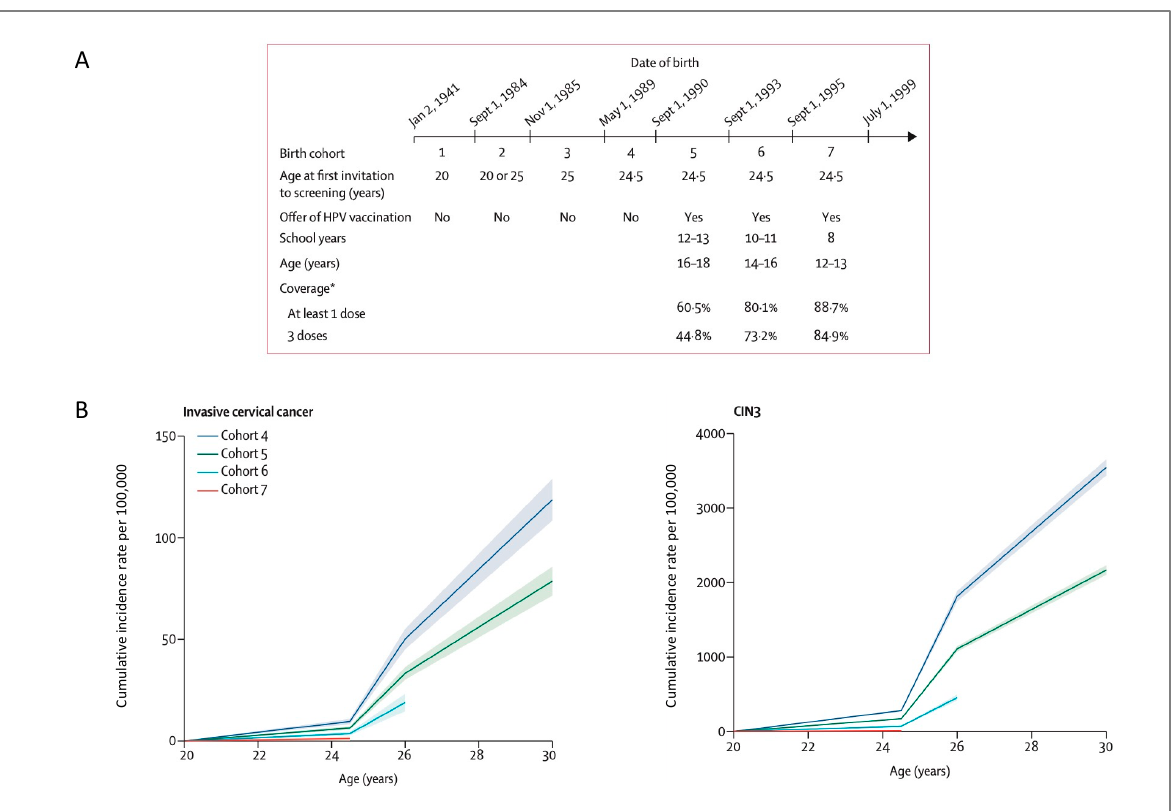
Figure 3. Cumulative incidence of cervical cancer and CIN3 using data from England showing a reduced incidence of cervical cancer and CIN3 in vaccinated cohorts (reproduced with permission from Falcaro et al. [76]) ( A ), schematic representation of birth cohorts [76] * Vaccine coverages include (where data are available) mop-up vaccinations (i.e. when females are vaccinated in a later year than the one in which they were first offered vaccination [76] ( B ), Cumulative incidence rates of invasive cervical cancer and CIN3 by birth cohort [76].